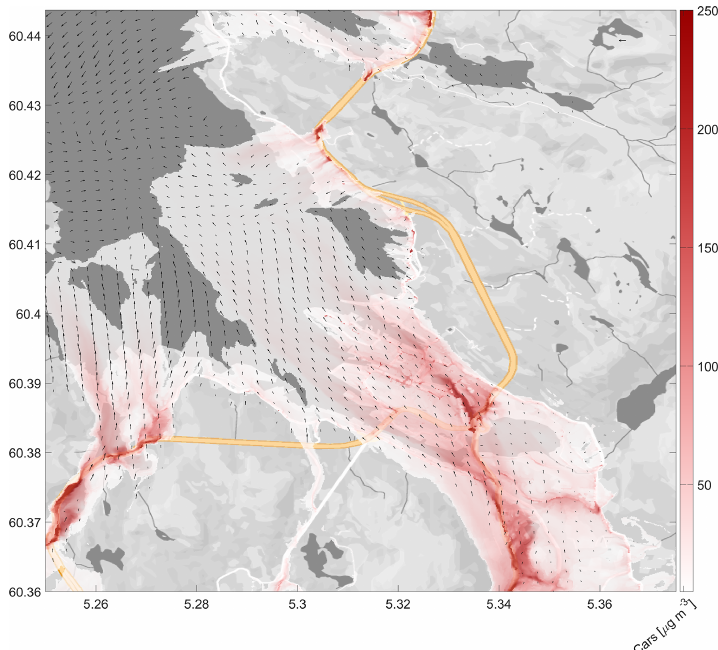
Figure 5. The simulated NO 2 concentration pattern in the baseline scenario ws01_wd01_ft01 in the central part of the model domain. The emission source is the road traffic (cars). The concentrations were sampled at 5m above the surface. Concentrations below 5µgm − 3 are omitted. The wind vectors characterise the flow 55m above the surface. The sampled data were averaged over the last 15min of the 6h dispersion run. The concentrations are given by semi-transparent colour shading overlaying the grayscale land and water surface taken from map data ©2019 Google.